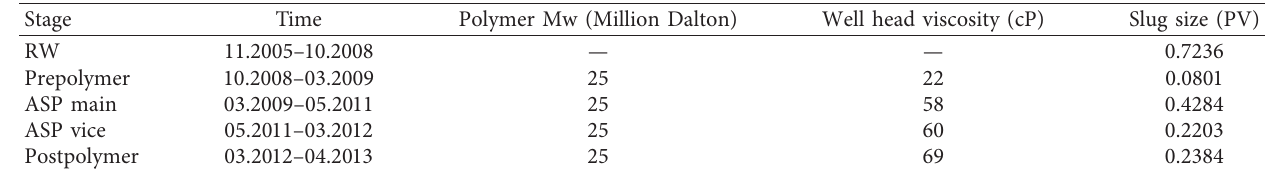
Table 18: WASP time table.